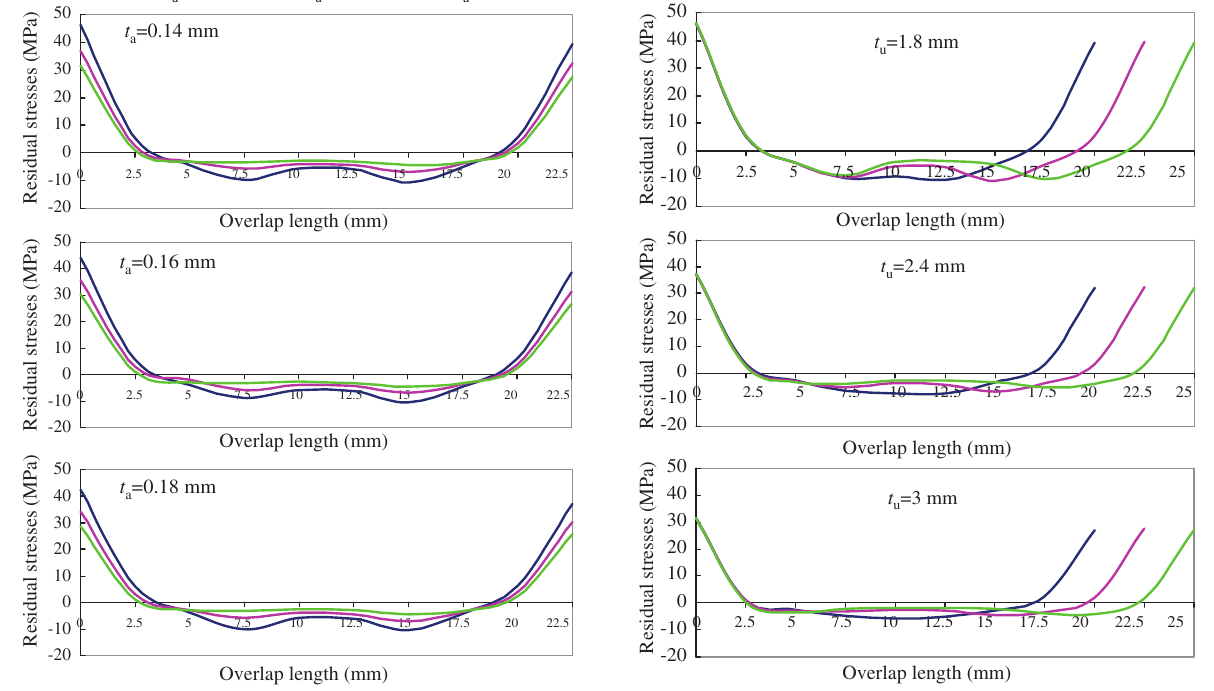
Figure 12 Effect of adhesive length on the residual shear stress for = 0.14 mm with different adherend adhesive thickness of t a